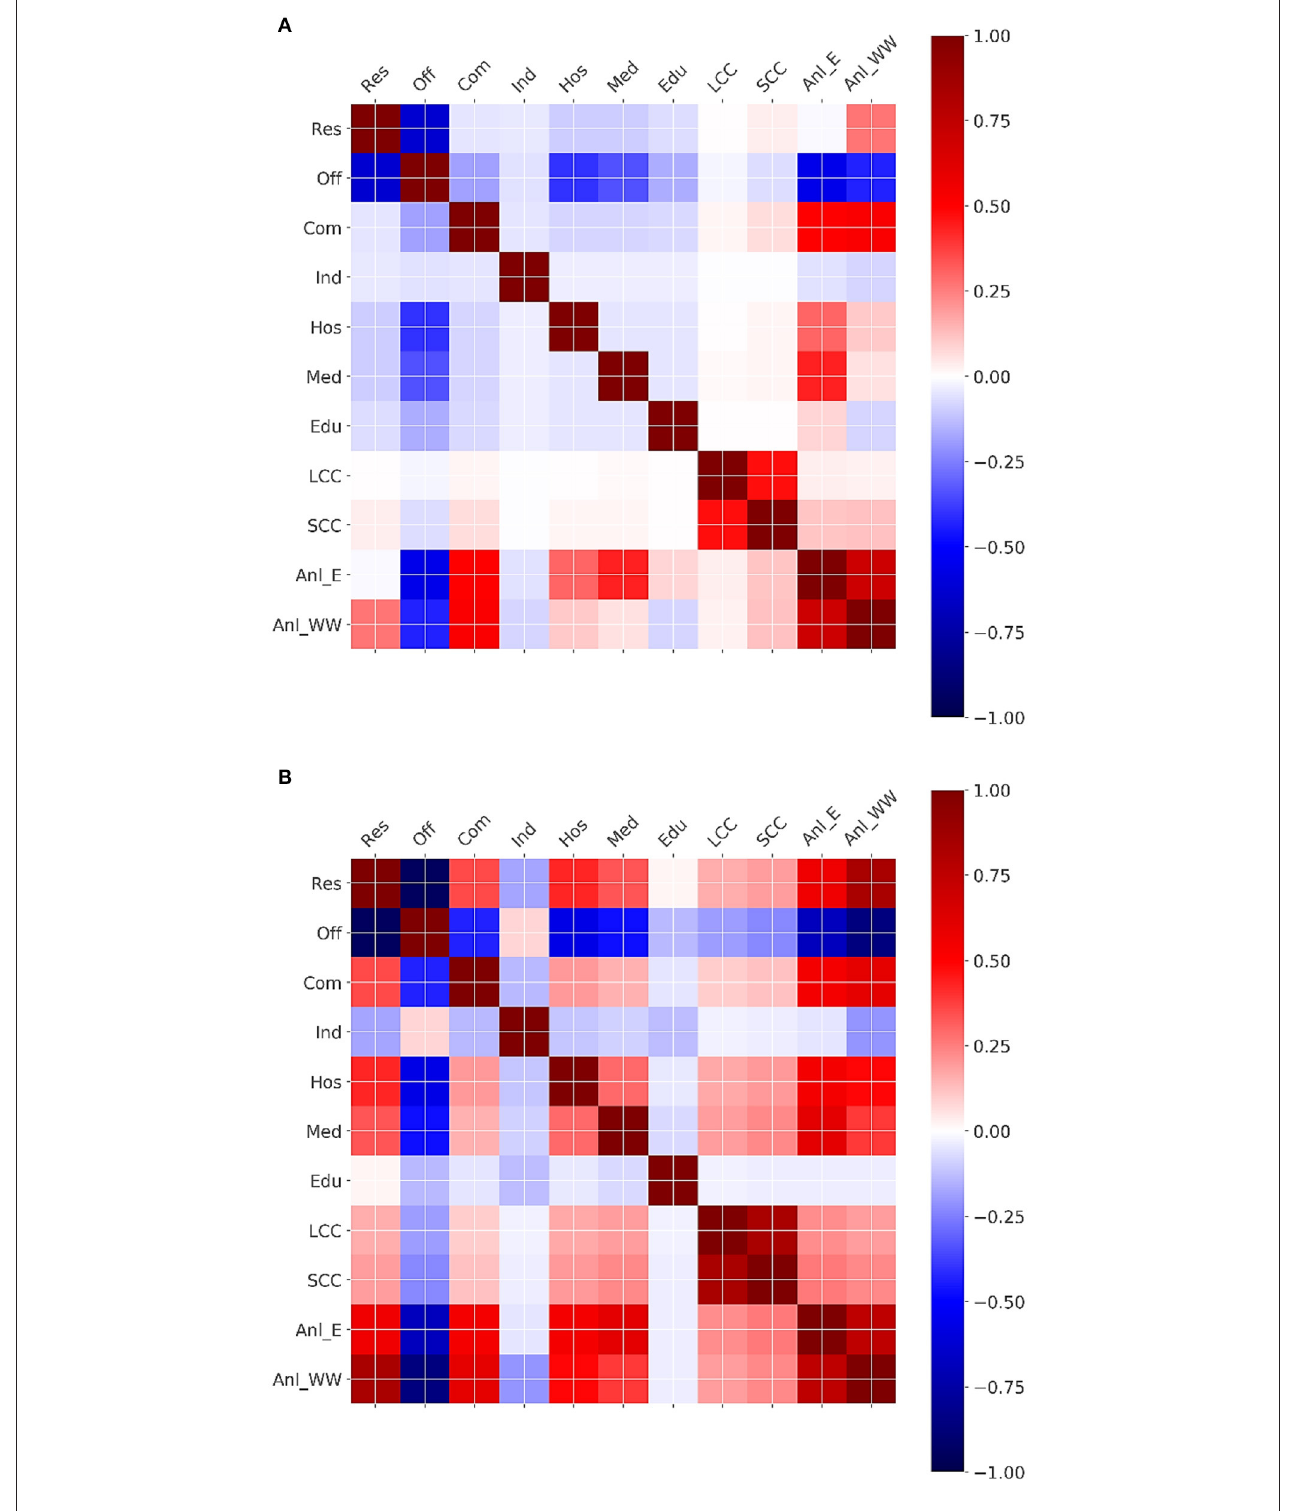
FIGURE 10 | Correlation matrix for building area percentages (symbols from Table 1 ), normalized LCC and SCC, normalized annual energy (Anl_E) and wastewater treatment demand (Anl_WW) across the admissible neighborhoods from (A) scenario 1 and (B) scenario 2.